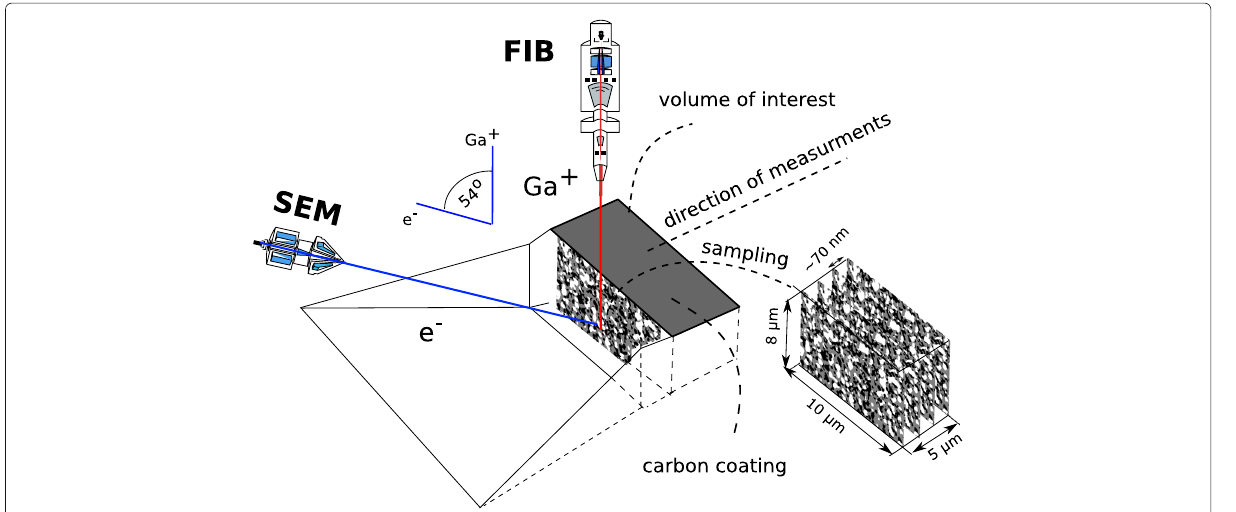
Fig. 3 The configuration of a dual beam